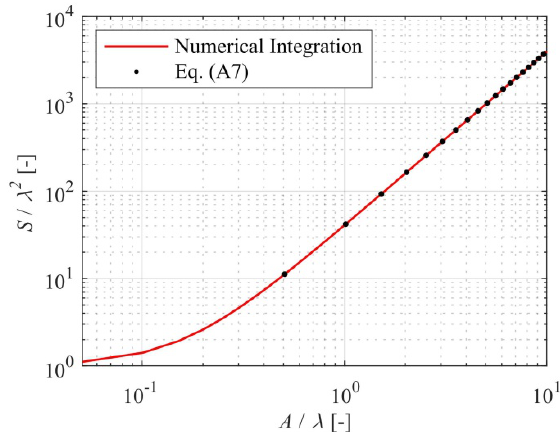
region. Figure A2. Numerical integration of the waved interfacial surface for a squared λ · λ region. 𝜆𝜆 · 𝜆𝜆